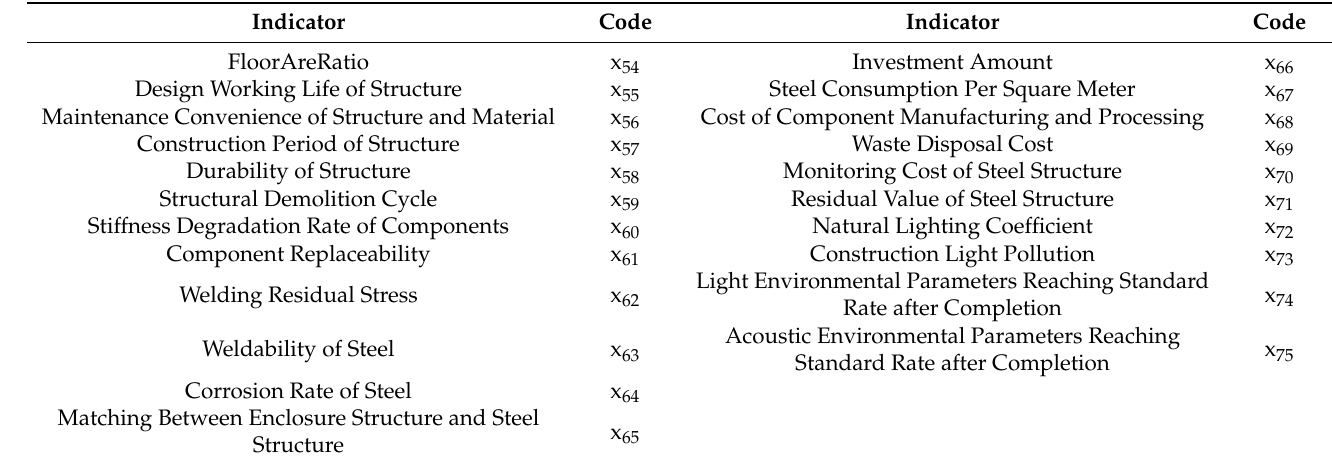
Table 6. Sustainability indicators for steel